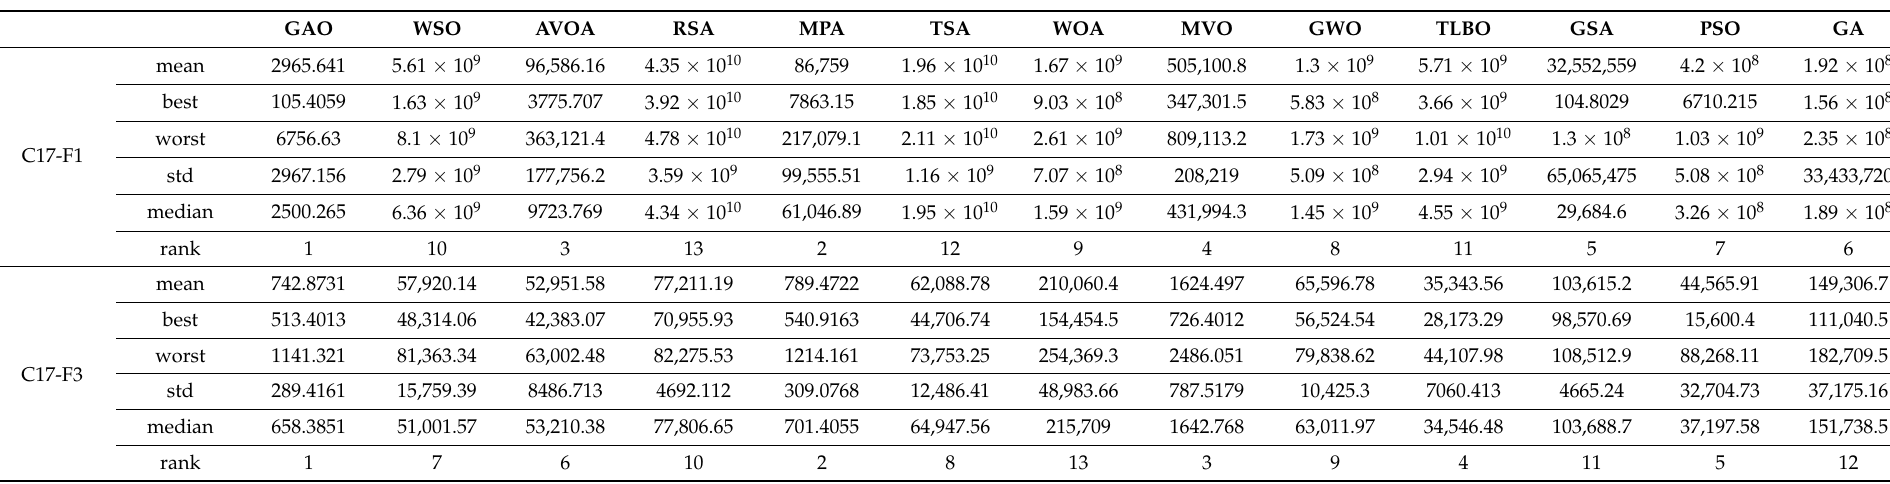
Table 3. Optimization results of the CEC 2017 test suite (dimension m =